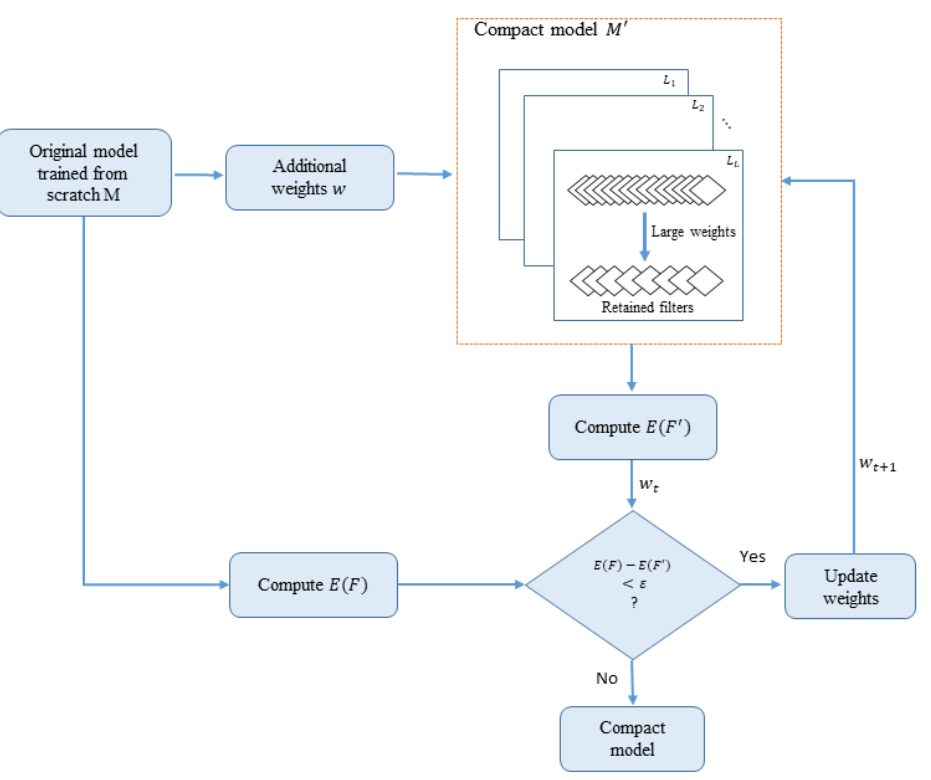
Figure 2. The proposed filter pruning approach. Here, w t represents the weight of the filter at the t th